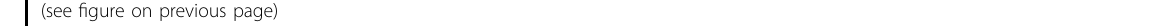
Fig. 7 SERPINA3 regulates cortical expansion through Glo1. a Differential representation heatmap of the different expression genes. b Gene ontology analysis for regulated genes based on RNA-seq data in E15 cKI f/ + mice. c Western blot analysis for Glo1 in cortex of WT and cKI f/ + mice. β -actin was detected as loading control. d ChIP-qPCR analysis for SERPINA3 binding region in the Glo1 promoter ( n = 3). e GFP + cell distribution in E15.5 mice after IUE at E13.5. Scale bar, 20 μ m. f Quanti fi cation for the percentage of GFP + cells in VZ/SVZ ( n = 4). g IF for SOX2 and TBR2 in E15.5 mice after IUE at E13.5. Outlined by dashed white lines, SOX2 + TBR2 − cells in expanded SVZ. Scale bars, 20 μ m (left), 5 μ m (right). h Quanti fi cation for the percentage of SOX2 + TBR2 − cells among GFP + cells in expanded SVZ ( n = 4). i Quanti fi cation for the percentage of SOX2 + cells among GFP + cells in expanded SVZ (control n = 3; SERPINA3 n = 4; SERPINA3 + Glo1-shRNA n = 5). j Quanti fi cation for the percentage of EdU + cells among GFP + cells (control n = 3; Glo1 n = 7). k IF for EdU in E15.5 mice after IUE at E13.5. Higher magni fi cation images show the EdU + GFP + cell (arrow, top right). Scale bars, 50 μ m, 10 μ m (top right). l Staining for DAPI in P0 mice after IUE at E13.5. Images 1 and 2 (DAPI) are high-magni fi cation images. Dashed white lines show the boundary of cortex. Scale bars, 100 μ m (top), 50 μ m (bottom). Two-tail unpaired t -test is used to analyze the data. n.s. no signi fi cant difference; P < 0.05 (*), P < 0.01 (**), P < 0.001